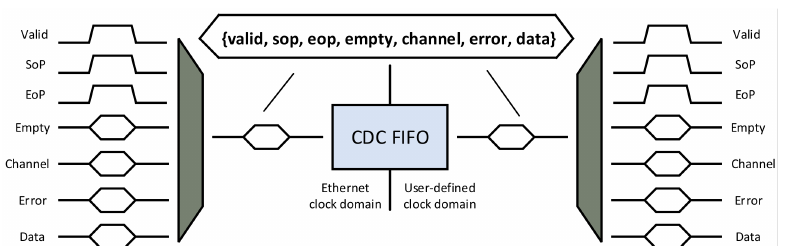
Figure 7. Design of CDC